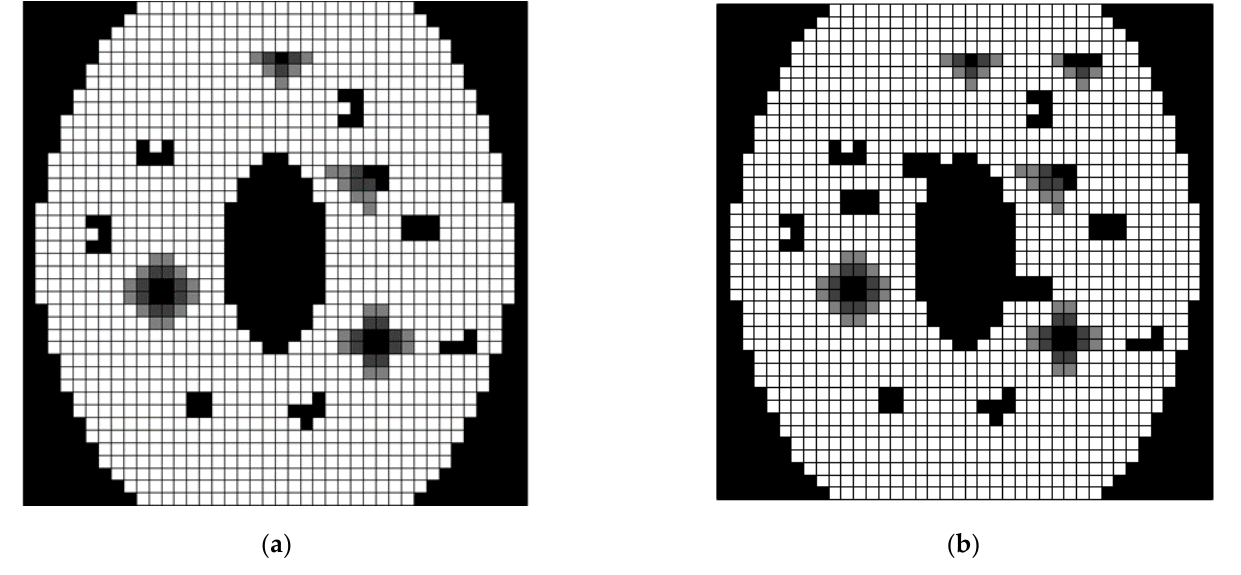
Figure 7. Raster maps used in experience: ( a ) Simple environment; ( b ) Complex environment.